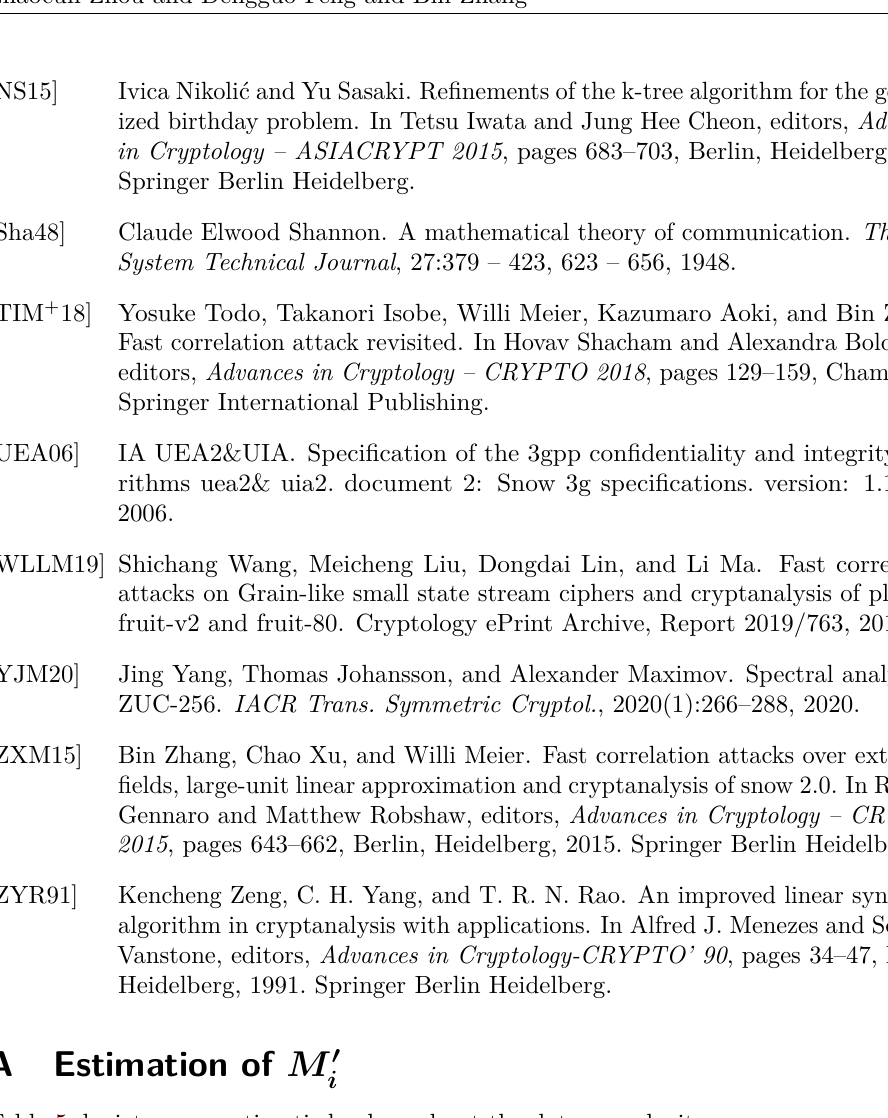
Table 5: Estimation of some M 0